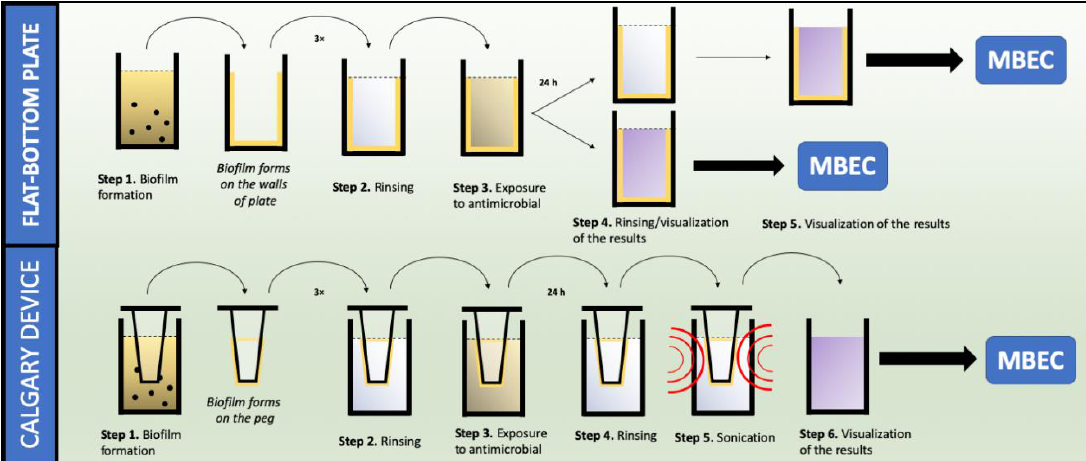
Figure 1. Example of microtiter plate and interpretation of microdilution results. MIC—minimum inhibitory concentration.